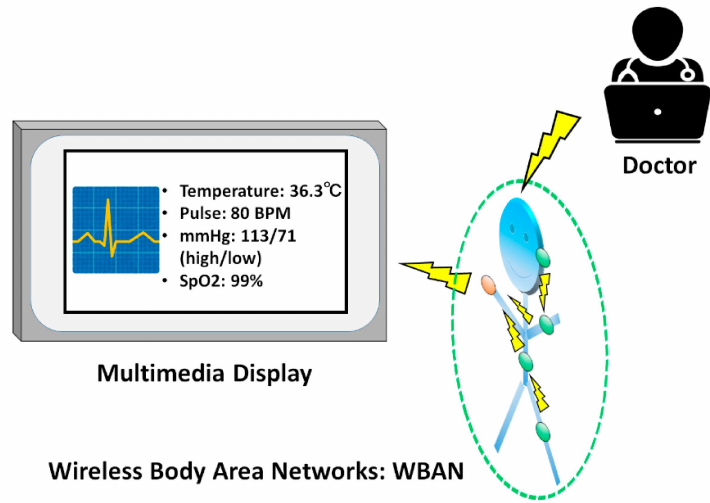
Figure 1. Example of a medical and healthcare system using